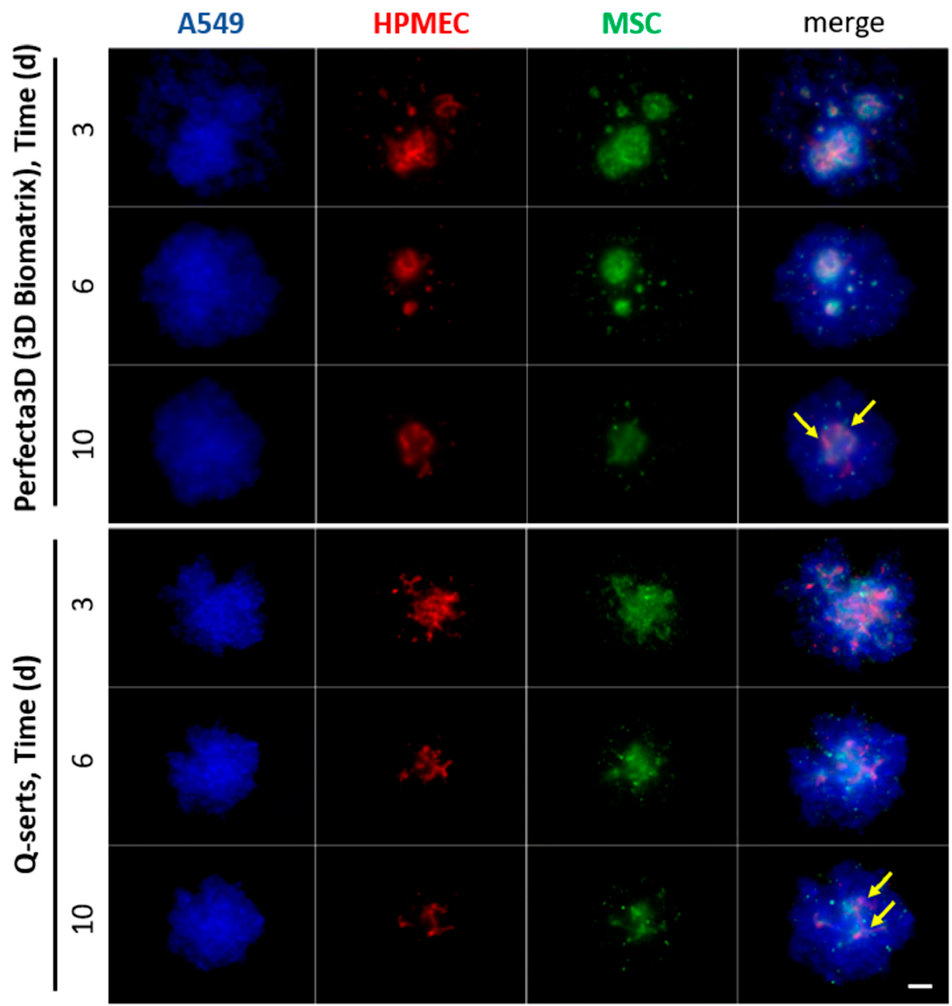
Figure 5. Time course of parallel culture of STEM spheroids in different hanging drop formats: 3D Biomatrix plate vs. Q-serts. A mixture of 25,000 cells (A549/HPMEC/MSC in ratio 5:3:2) was initially seeded. Imaging was done on days 3, 6, 10. Yellow arrows indicate central aggregates of HPMEC and MSCs. Scale bar 200 µm.